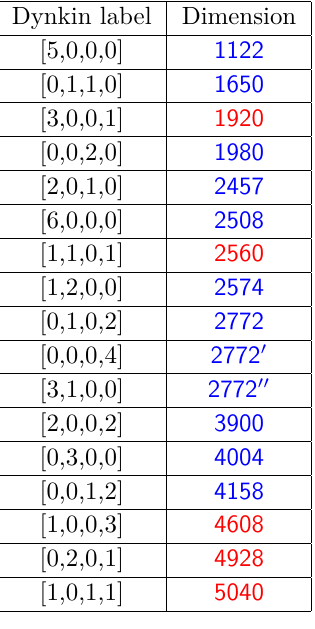
Table 3 . so (9) irreducible representations #2